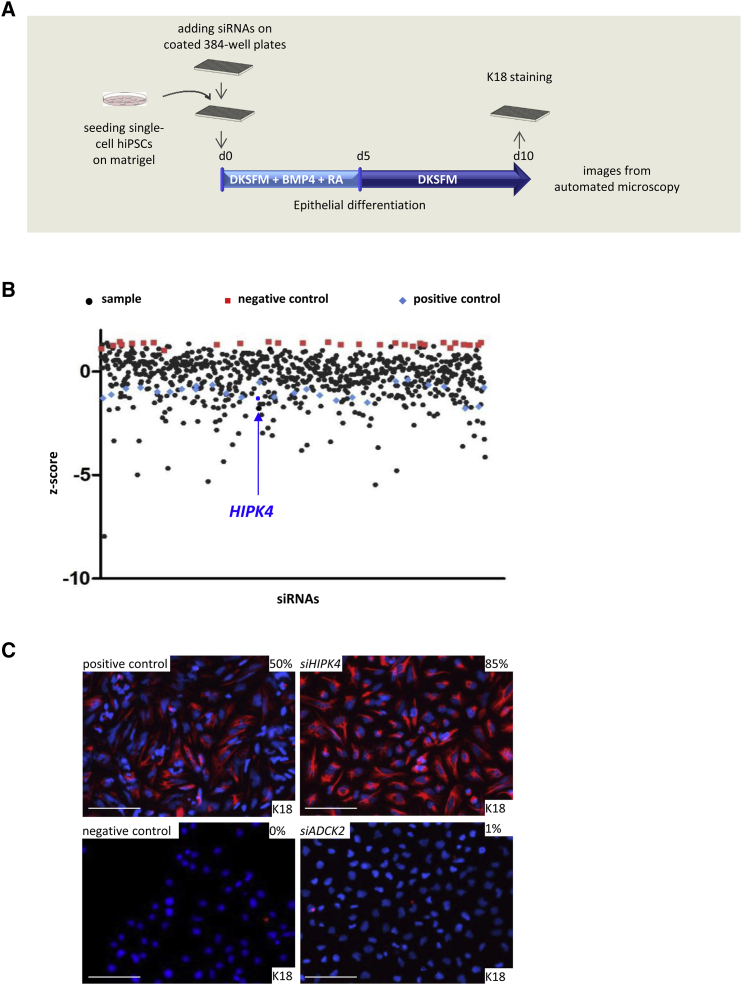
High-Throughput RNAi Screen Identifies HIPK4 as an Inhibitor of Skin Epithelial Differentiation(A) Schematic of the RNAi screen workflow. Single hiPSCs were reverse transfected with a kinome RNAi library and differentiated into epithelial precursors. At day 10, immunofluorescence staining against K18 was performed and cells were imaged by automated microscopy.(B) Scatterplot of data where each siRNA from the screen at day 10 is represented as the Z-score value. Plot includes negative (red, Z score = +1.3) and positive (blue, Z score = −1) controls. Positive control condition corresponds to cells transfected with siControl and differentiated for 10 days. Negative control condition corresponds to cells maintained in pluripotency condition for 10 days. Arrow marks siRNA against HIPK4 as a sample with increased numbers of K18+ cells compared with the positive control.(C) Representative images of K18 immunostaining and quantification of percentage of positive cells after 10 days of differentiation with or without siHIPK4 or siADCK2. Scale bar, 100 μm.